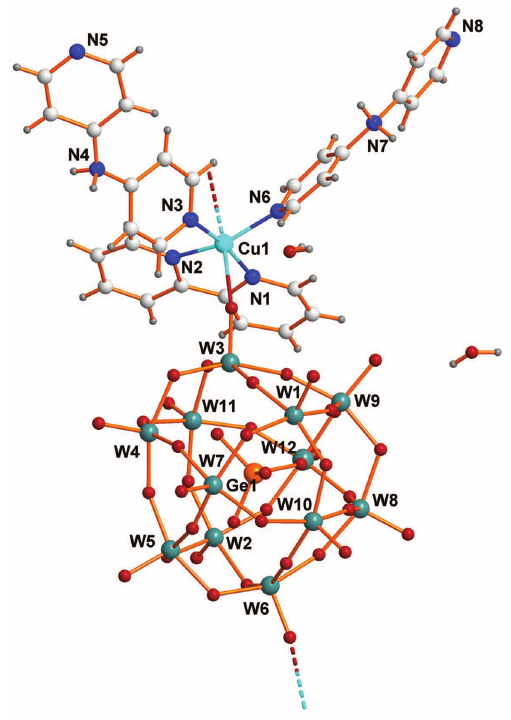
Table 1: Data collection and